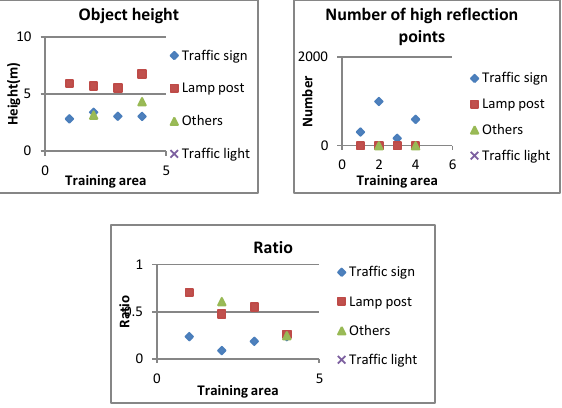
Figure 6: Statistic analysis on three parameters in knowledge-based classification (dataset